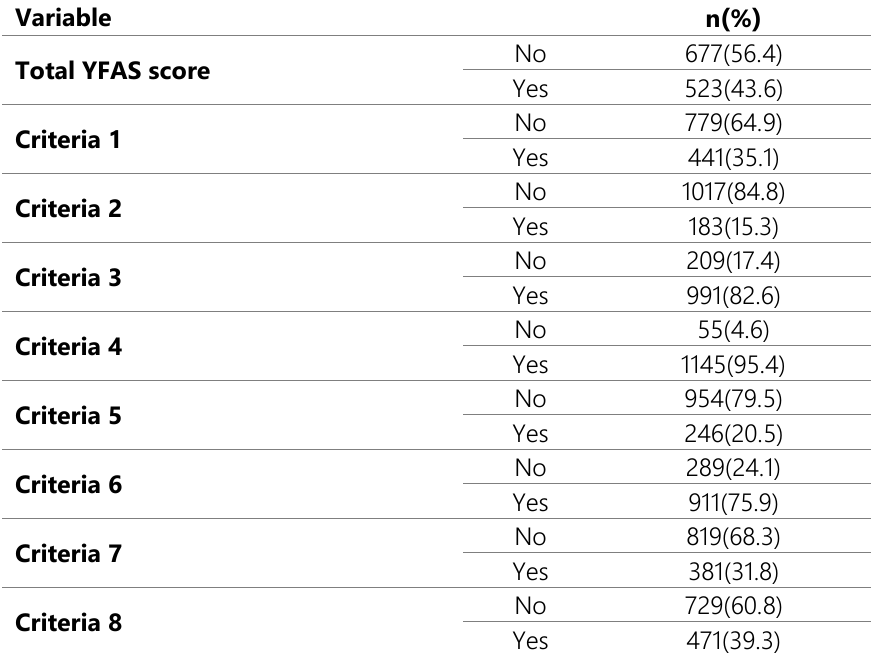
Table 2: Presence or absence of food addiction among the participants based on the total YFAS score and 8 criterions.